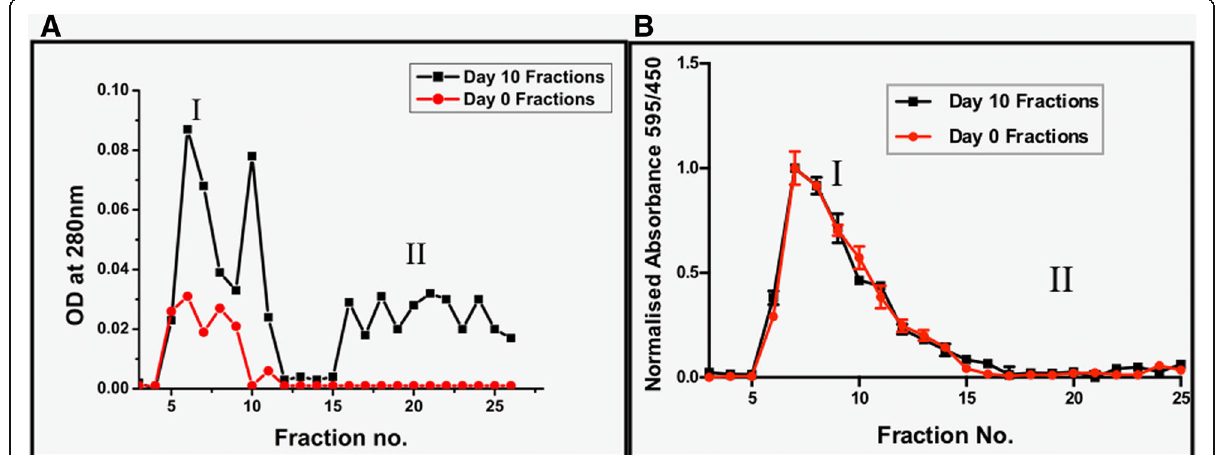
Fig. 3 Elution profile of day 0 Fruc-Hb (red) and day 10 Fruc-Hb (black) fractions. UV absorbance profile measured at 280 nm ( a ) and Bradford assay for the presence of proteins ( b ) of fractions from day 0 Fruc-Hb and day 10